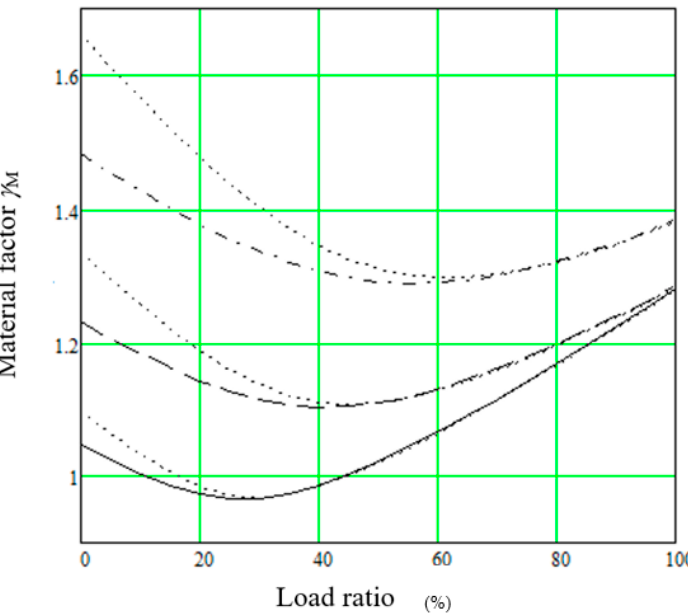
Figure 4. The material factor calculated for V M = 0.15, β 50 = 3.83. The horizontal dashed line denotes γ M = 1.15.